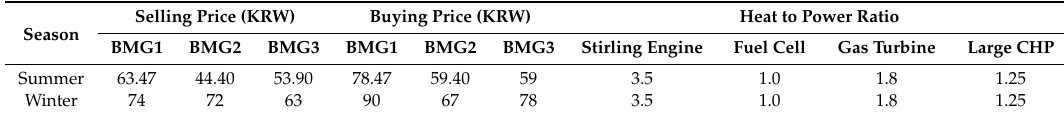
Table 2. Season-wise heat trading prices of BMGs and heat to power ratios of CHPs. Table 1. Energy generation limits and energy efficiency ratings.